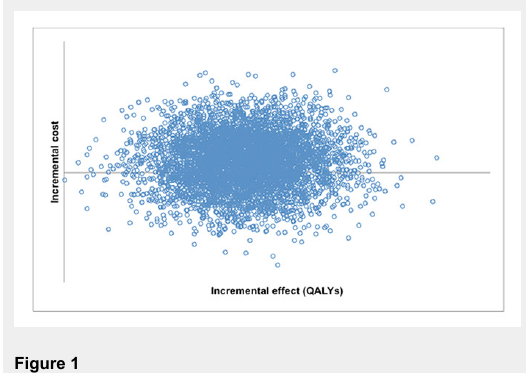
Results of the probabilistic sensitivity analysis. Incremental costs and effects are calculated as ticagrelor minus generic clopidogrel.